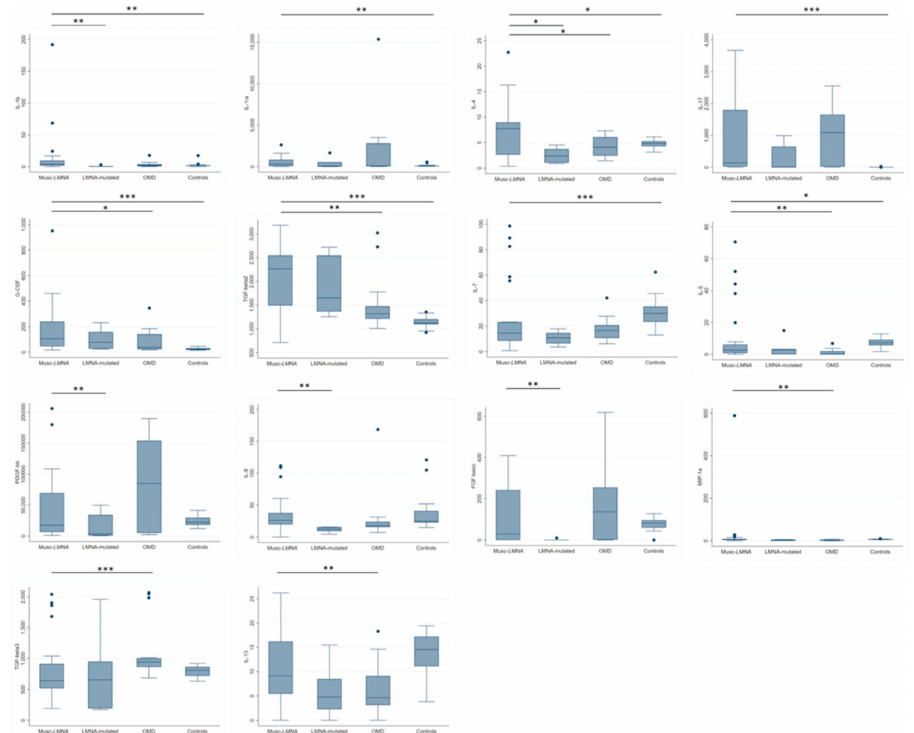
Figure 1. The immune mediator expression in serum samples from Musc-LMNA and LMNA-mutated patients, patients with other muscular disorders (OMD) and healthy controls. Among the 30 immune mediators analyzed, the serum concentration levels of six molecules (interleukin-1 β (IL-1 β ), p = 0.0024; IL-1 receptor antagonist (IL-1ra), p = 0.0066; IL-4, p = 0.0314; IL-17, p < 0.0001; granulocyte colony-stimulating factor (G-CSF), p < 0.0001; TGF- β 2, p < 0.0001) were significantly higher in the Musc-LMNA patients than in healthy controls. IL-5 ( p = 0.0029) and IL-7 ( p = 0.0011) levels were significantly decreased in the Musc-LMNA patients compared to controls. IL-1 β ( p = 0.0032), IL-4 ( p = 0.0120), platelet-derived growth factor-BB (PDGF-BB ( p = 0.0161)), IL-8 ( p = 0.0038) and basic fibroblast growth factor (bFGF ( p = 0.0041)) were higher in the Musc-LMNA patients compared to the LMNA-mutated patients. In the comparison between Musc-LMNA and OMD groups, IL-4 ( p = 0.0309), G-CSF ( p = 0.0194), TGF- β 2 ( p = 0.0033), IL-5 ( p = 0.0080), macrophage inflammatory protein-1alpha (MIP-1 α ( p = 0.0120)) and IL-13 ( p = 0.0147) were higher in Musc-LMNA, whereas TGF- β 3 ( p = 0.0007) was lower in this group. Dark horizontal lines represent the means, with the box representing the 25th and 75th percentiles, and the whiskers representing the 5th and 95th percentiles. * p < 0.05; ** p < 0.01; *** p <